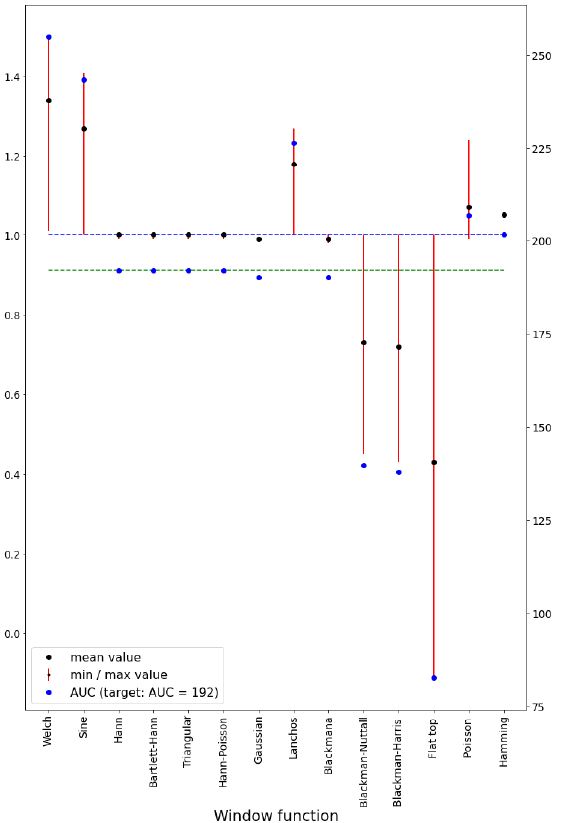
Figure 3. Presentation of the values of the average, minimum, and maximum values of the weights of the analyzed windows. It was assumed that the images overlapped in 50%. Numerical values were determined for the overlap area. Table 2. Assessment of the quality of combining images with the use of windows. For methods marked with “*”, histogram adjustment was applied before